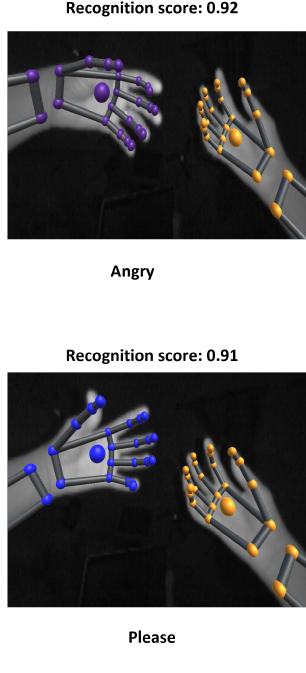
Figure 13. Misclassified